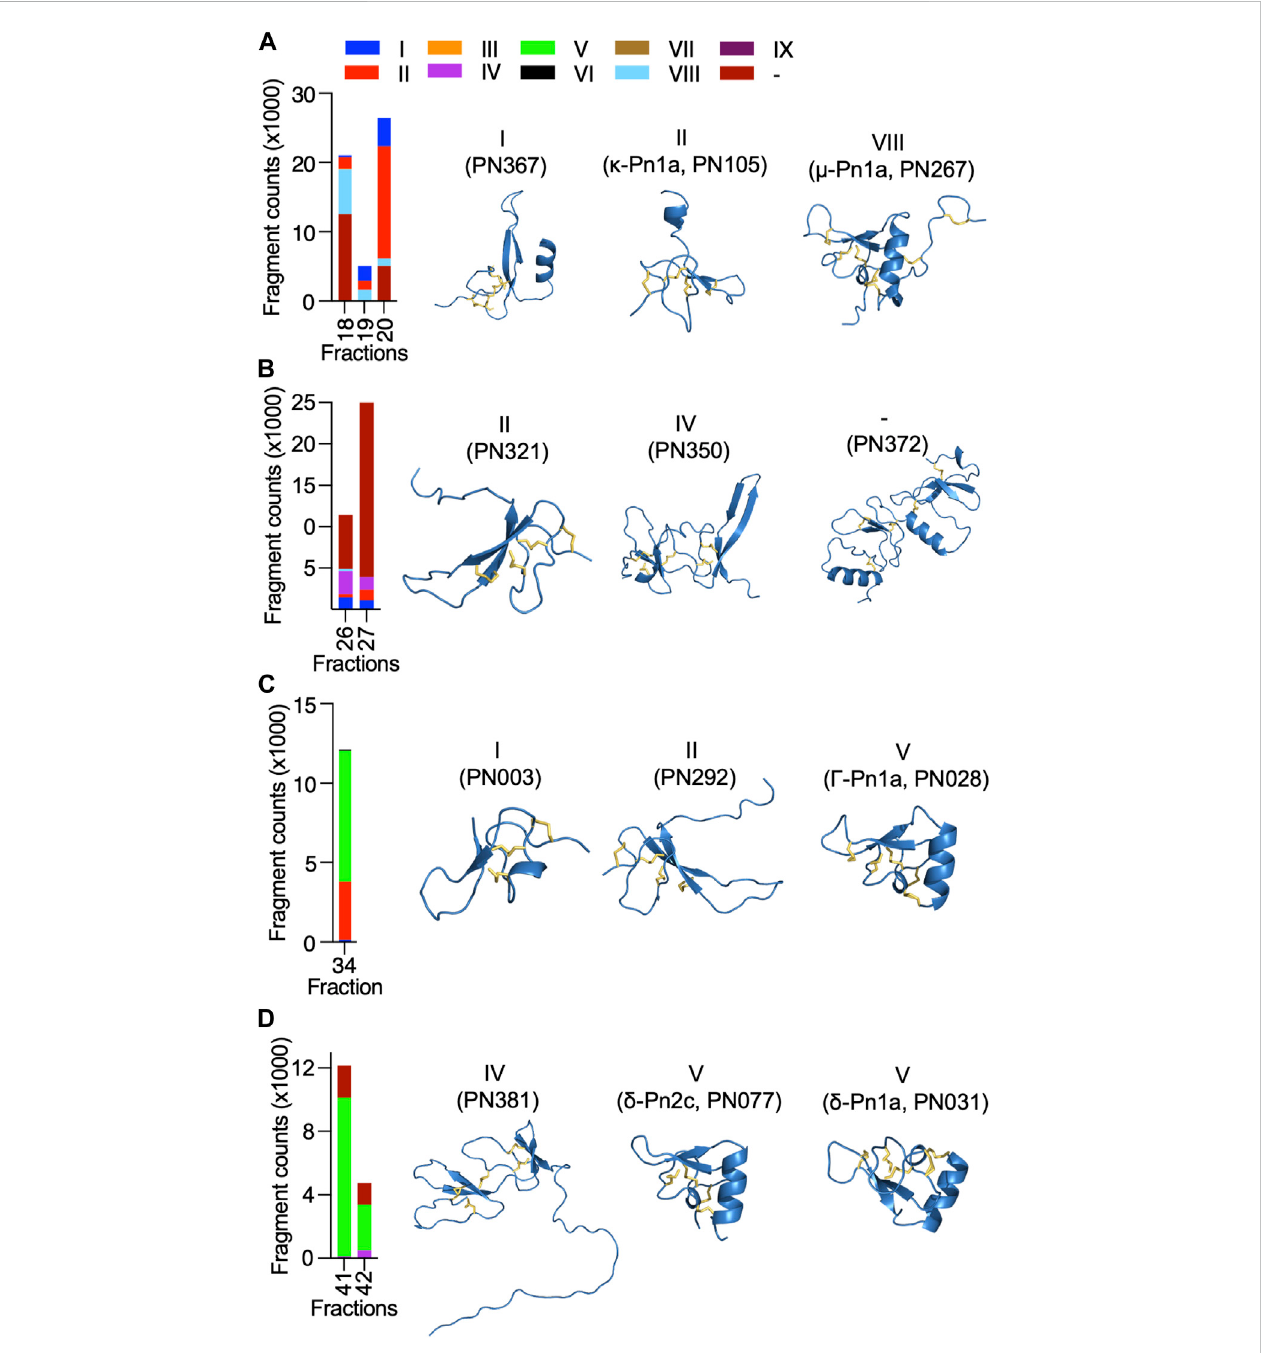
FIGURE 4 Diversity and estimated levels of cysteine-rich scaffolds identi fi ed in highly neuroactive RP-HPLC fractions from the venom of P. nigriventer , and their predicted 3D structures. (A) Fractions 18 – 20 comprised high levels of scaffolds I, II and VIII represented by the 3D structures of PN367, PN105 and PN267, respectively. (B) Fractions 26 and 27 comprised high levels of scaffolds II, and IV, and an unde fi ned scaffold represented by the 3D structures of PN321, PN350 and PN372, respectively. (C) Fraction 34 comprised high levels of scaffolds I, II, and V represented by the 3D structures of PN003, PN292 and PN028, respectively. (D) Fractions 41 and 42 comprised high levels of scaffolds IV and V represented by the 3D structures of PN381, and PN077 and PN031,